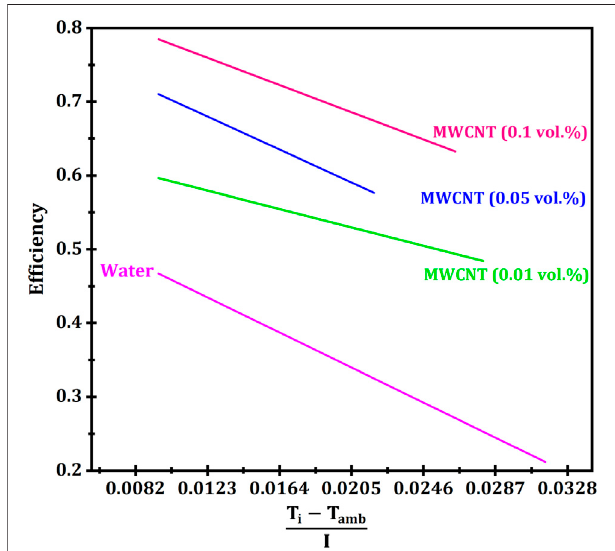
FIGURE 3 | The variations of Q s and SHF parameters.